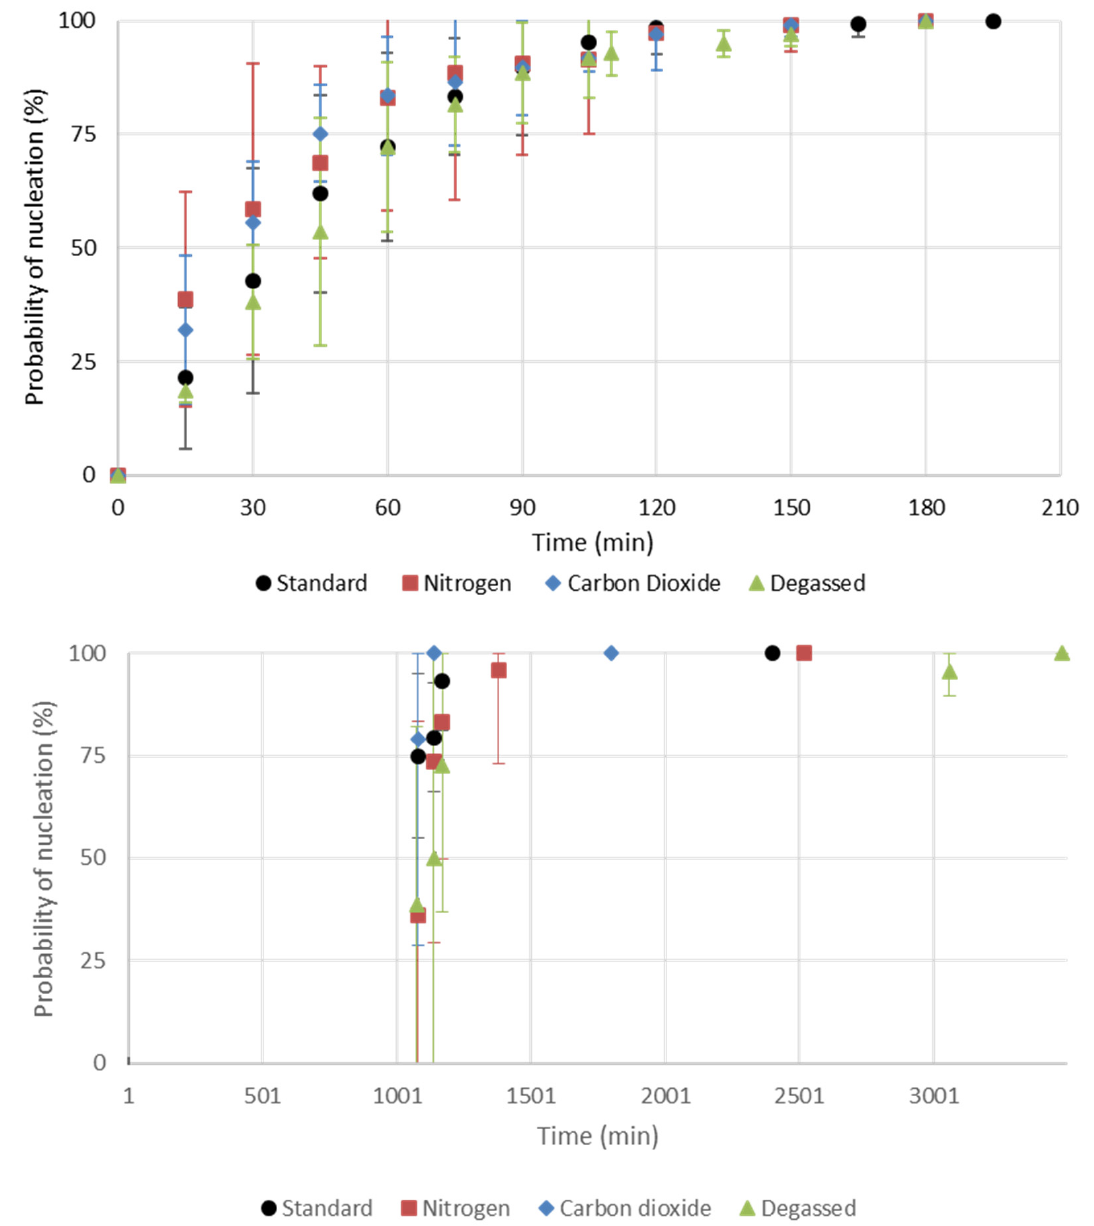
Figure 4. Influence of degassing and gas bubbling on the probability of NPLIN ( at the top ) and the probability of spontaneous nucleation ( at the bottom ) as a function of time (one pulse at 85.6 mJ). “Standard” stands for no solution treatment; “Nitrogen” and “Carbon Dioxide” are the gas used for bubbling; “Degassed” is solution degassed by ultrasounds.